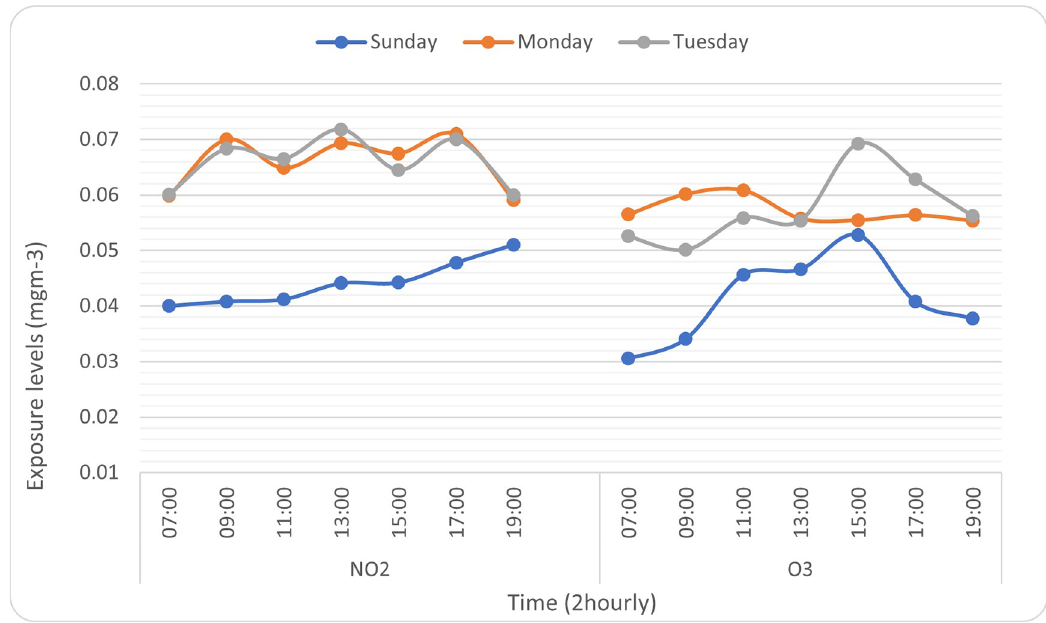
Fig 2. NO 2 and O 3 levels showing weekly